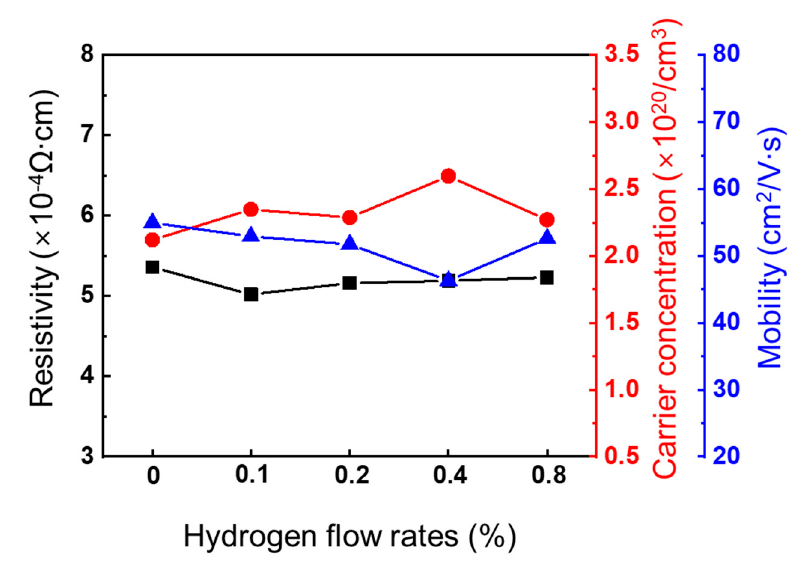
Figure 2. Electrical properties of In − Zn − O thin films as a function of hydrogen flow rates.